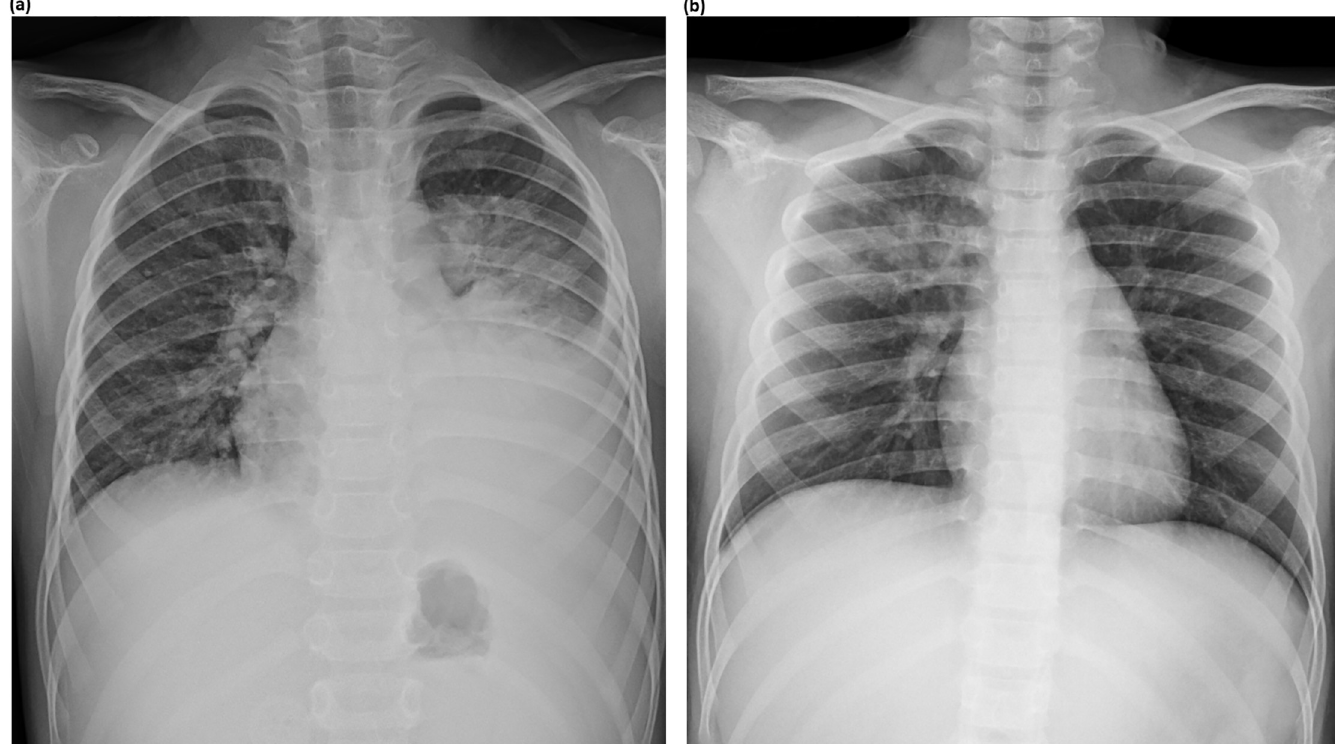
Fig 2. Determination of the dominant radiographic finding. (a) A 15-year-old boy with Mycoplasma pneumoniae pneumonia. Chest radiograph shows lobar consolidation in the left lower lobe and parahilar peribronchial infiltration in the left lung. In this case, lobar consolidation was regarded as the dominant finding, and categorized as lobar or segmental consolidation . (b) Chest radiograph of a 9-year-old girl with Mycoplasma pneumoniae pneumonia shows both a localized reticulonodular opacity and a patchy opacity in the right upper lung. In this case, the focal reticulonodular opacity was regarded as the dominant finding, and categorized as localized reticulonodular infiltration